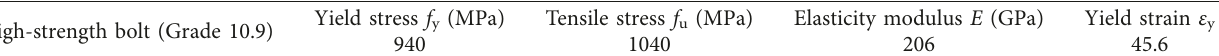
Table 3: Material properties of the